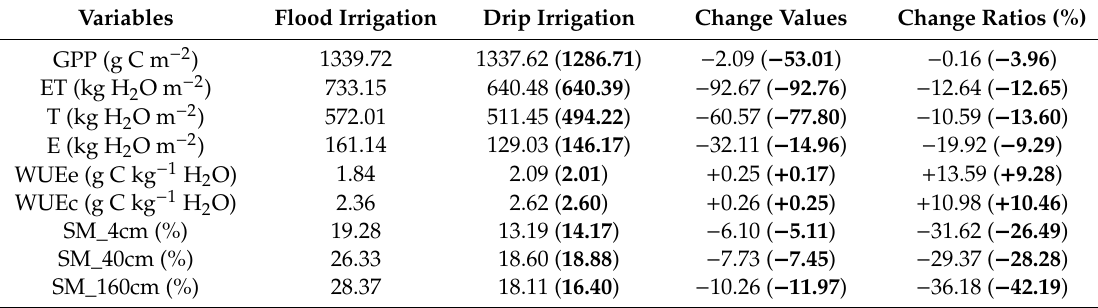
Figure 7. Annual variations of gross primary production (GPP)( a ), evapotranspiration (ET) components (i.e., vegetation transpiration (T) and soil evaporation (E)), T fraction of the ET (T/ET) and accumulated annual precipitation (AAP)( b ), water use efficiency (WUE) at both ecosystem and canopy levels (i.e., WUEe and WUEc)( c ), and soil moisture (SM) at different layers( d ). Table 2. Statistics of annual gross primary production (GPP), evapotranspiration (ET) components (i.e., vegetation transpiration (T) and soil evaporation (E)), and water use e ffi ciency (WUE) before and after using the drip irrigation strategy. The symbols “ + ” and “ − ” represent increased and decreased, respectively. Since the di ff erent intensity and frequency of drip irrigation practice in di ff erent years (the data had a relatively large amount of irrigation in 2017), we used both the data of 2018 and the average data of 2017–2018 (the bold number in brackets) to represent the e ff ects of the drip irrigation strategy. Soil moisture (SM) at di ff erent layers were